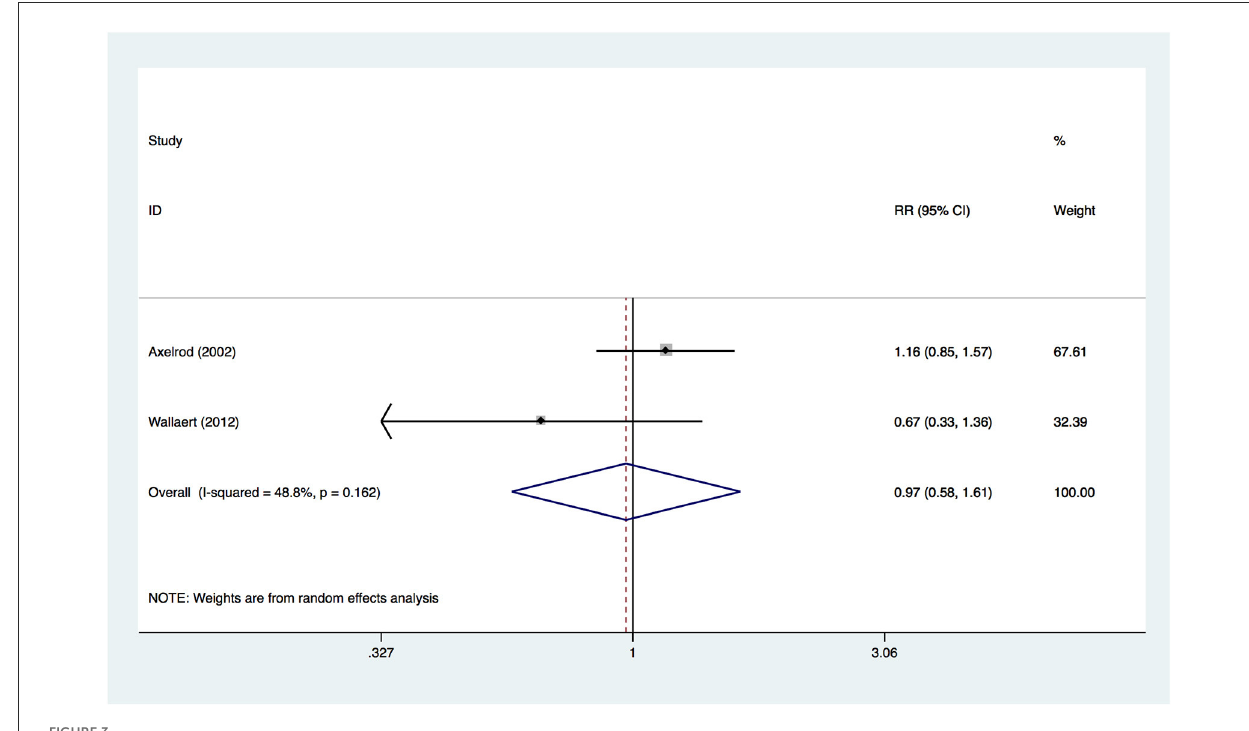
FIGURE3 Forest plot for risk of in-hospital mortality.